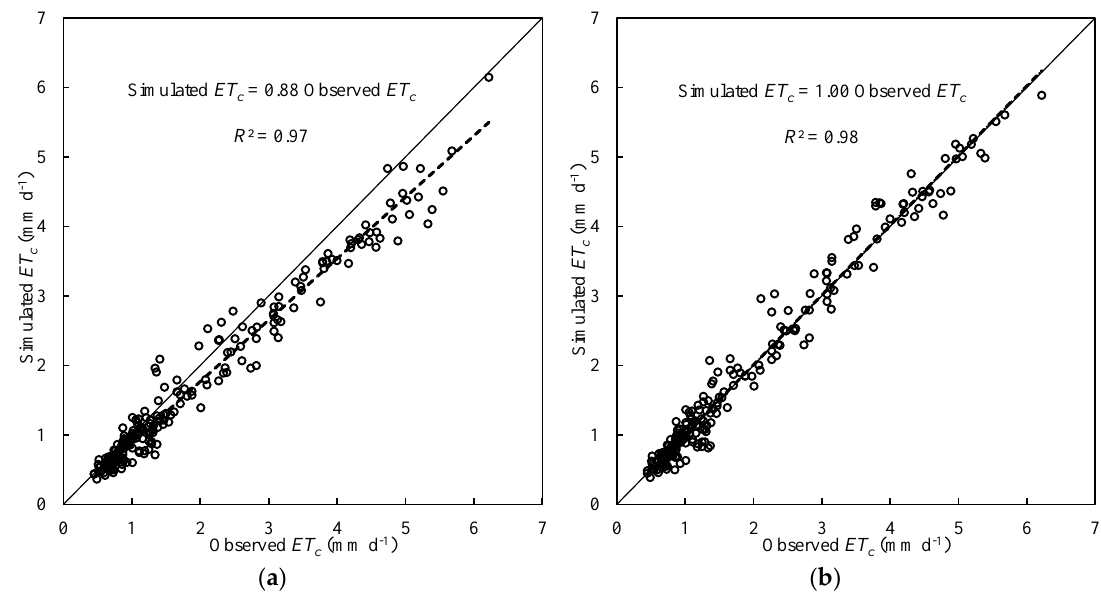
Figure 6. Comparison of observed and simulated daily winter wheat evapotranspiration (ET c ) during the whole growth period in T1 using the crop coefficients ( a ) suggested by the FAO-56 and ( b ) optimized by the genetic algorithm (GA).